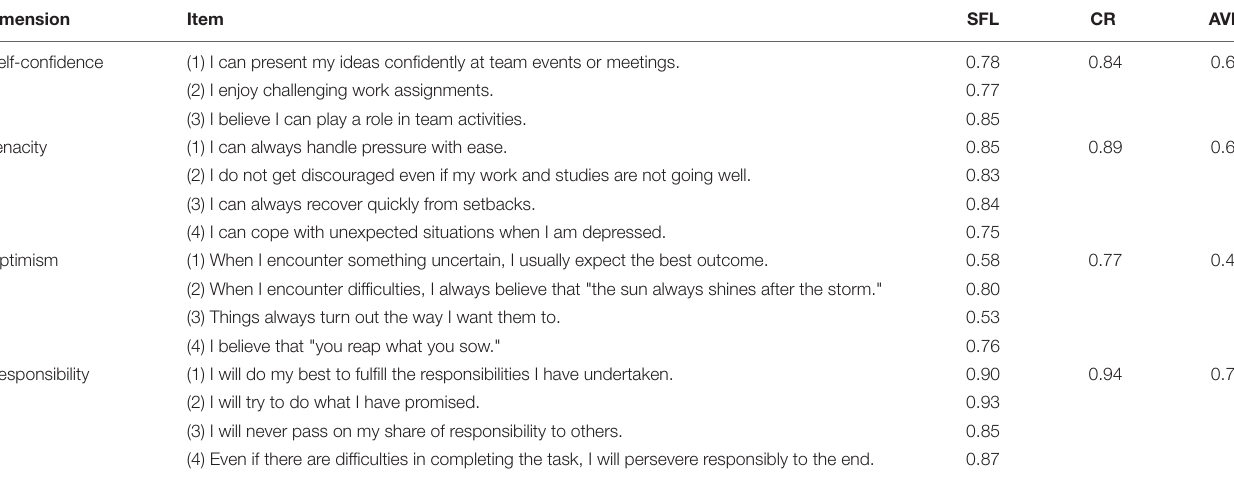
TABLE 4 | Confirmatory factor analysis of the psychological capital scale. Dimension Item SFL CR AVE Self-confidence